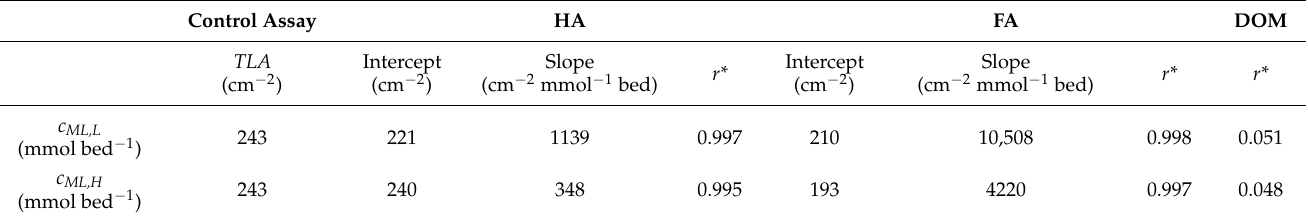
Table 1. Regression analysis parameters of the linear correlations between the total leaf area ( TLA ) of lettuce, and c ML,L or c ML,H for the HA, FA and DOM extracts. TLA values were obtained from a crop field assay using the composts and the fertiliser whose extracts were characterized by Cd 2+ titrations. The values from CVA were not included in the correlation